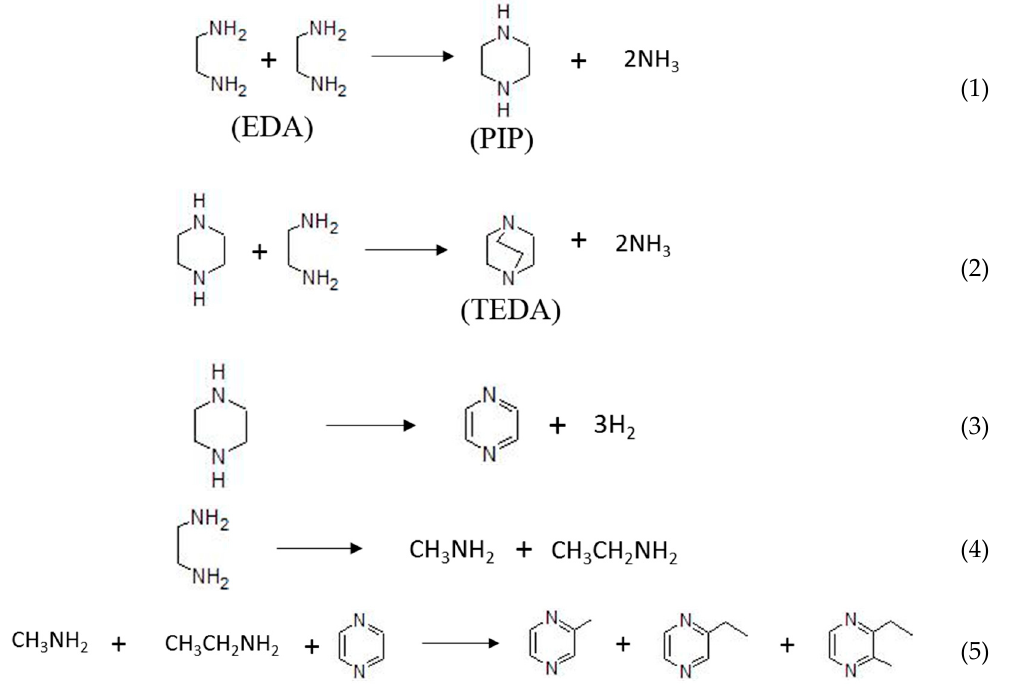
Scheme 1. The main reaction paths of ethylenediamine (EDA) over solid acid catalyst [8,11].((1) - (2) : Main reactions; (3)-(5): Side reactions)